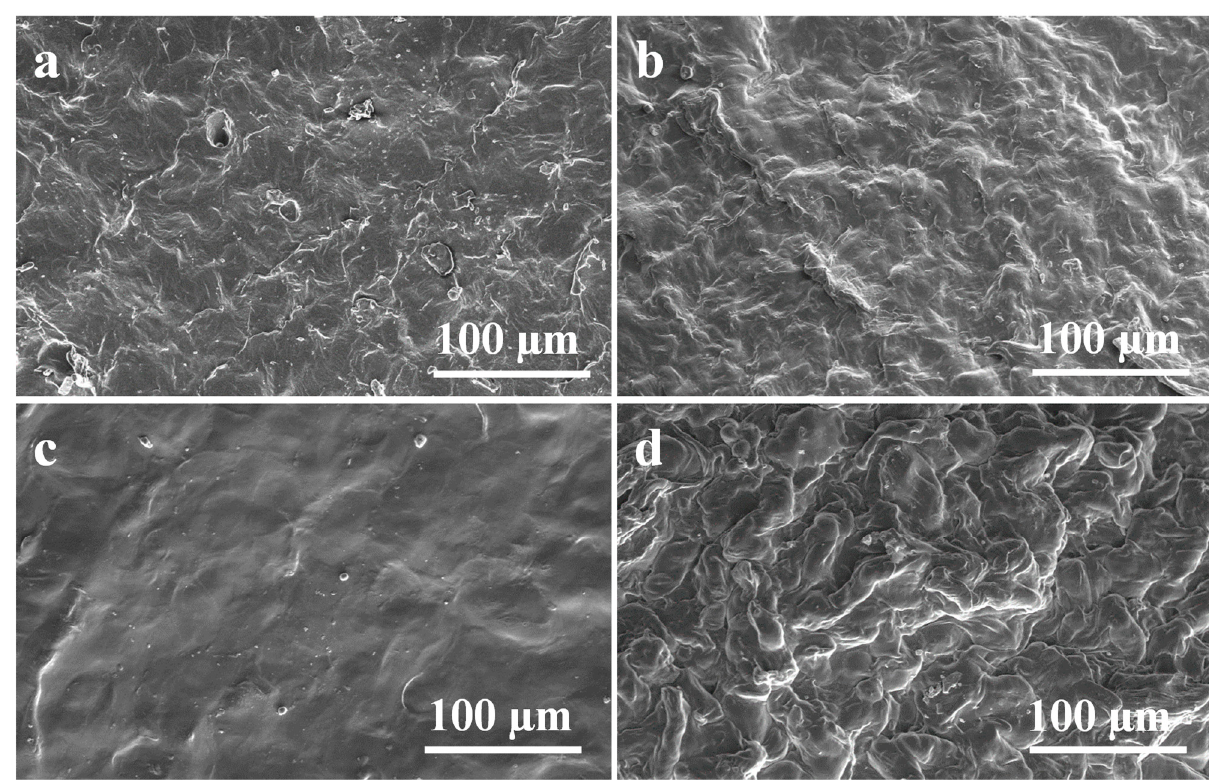
Figure 5. SEM images of surface morphology of dry ( a ) CG01, ( b ) CG02, and swollen ( c ) CG01, ( d ) CG02 hydrogels after immersion in PBS for 48 h.